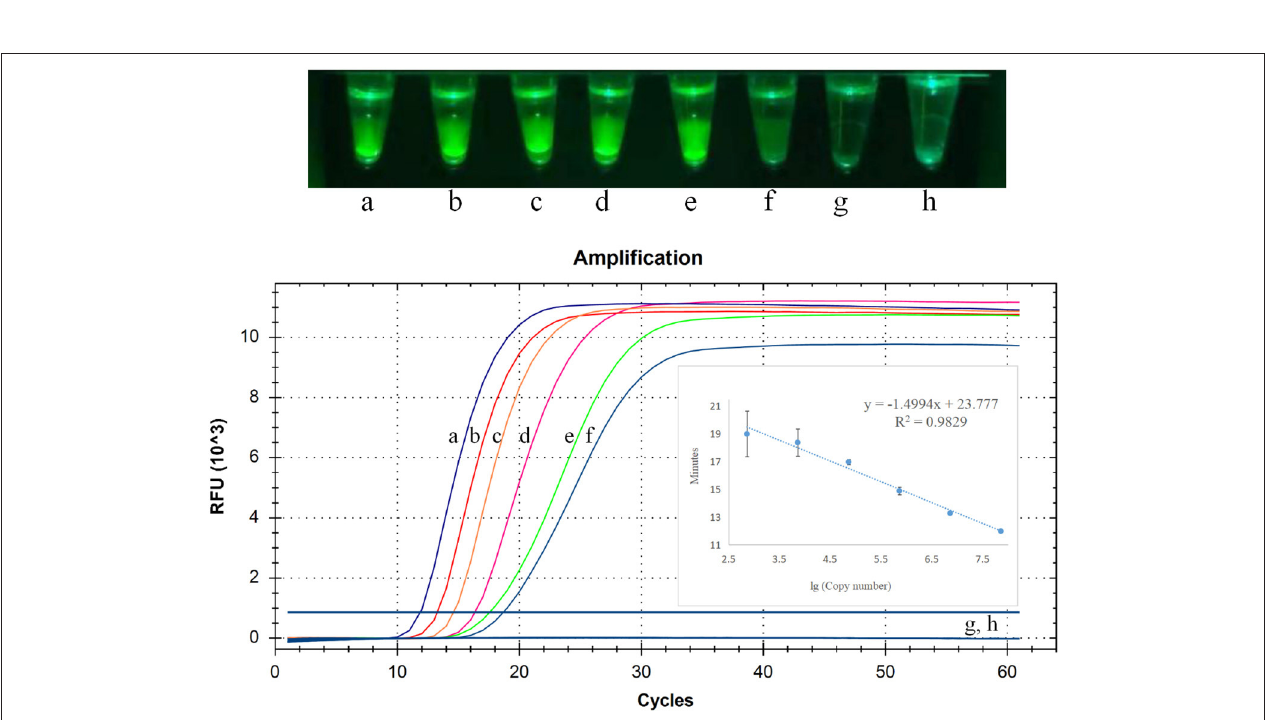
FIGURE 4 | Limit of detection of cleaved probe-based reverse transcription loop-mediated isothermal amplification (CP-RT-LAMP) assay. Serially diluted standard RNA of porcine deltacoronavirus (PDCoV) was used at the following concentrations: (a) 2.5 × 10 6 copies/ µ L, (b) 2.5 × 10 5 copies/ µ L, (c) 2.5 × 10 4 copies/ µ L, (d) 2.5 × 10 3 copies/ µ L, (e) 2.5 × 10 2 copies/ µ L, (f) 2.5 × 10 1 copies/ µ L, (g) 2.5 × 10 0 copies/ µ L, (h) negative